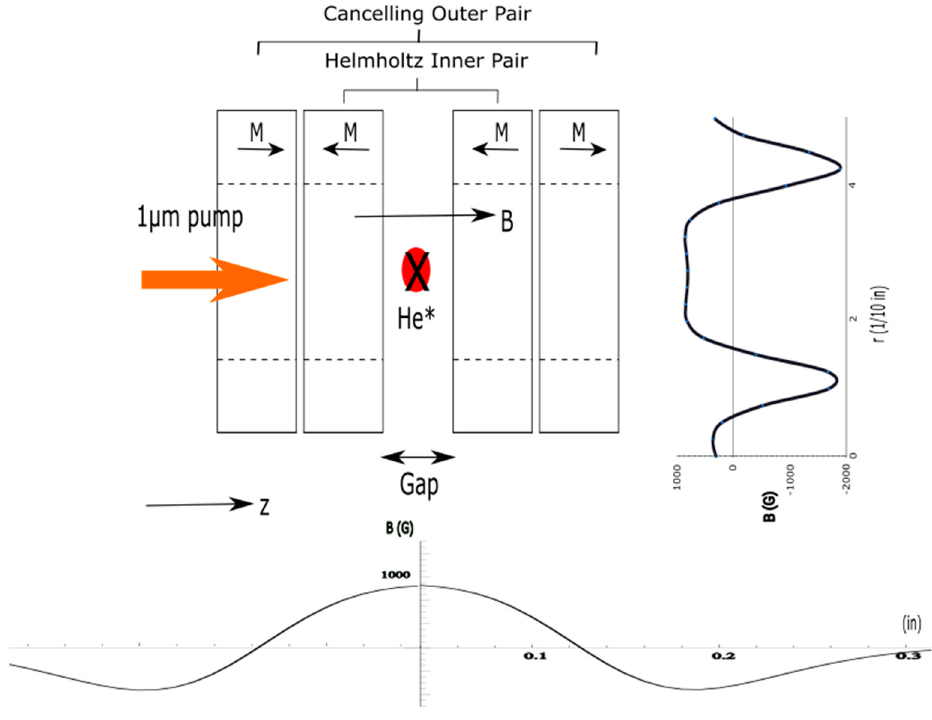
Figure 3. Created magnet assembly: bottom, axial (z) B z field; right: mid-plane transverse (x or ρ ) B z field.